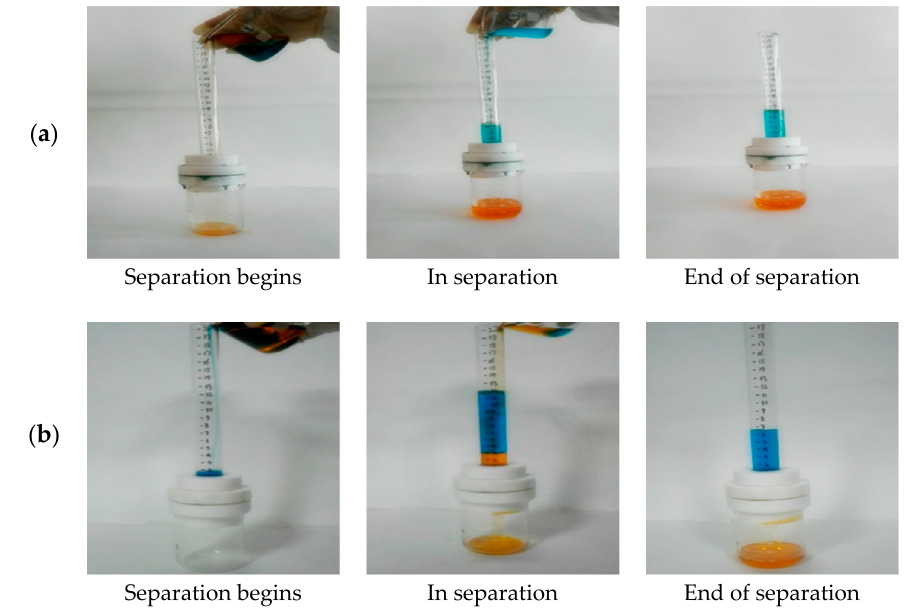
Figure 9. Separation effect diagram of oil-water mixture using parabolic membranes: ( a ) benzene-water; ( b ) carbon tetrachloride-water.